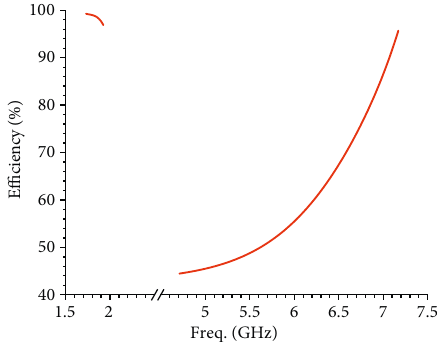
Figure 9: Radiation efficiency (simulated) of the proposed OBS Antenna.